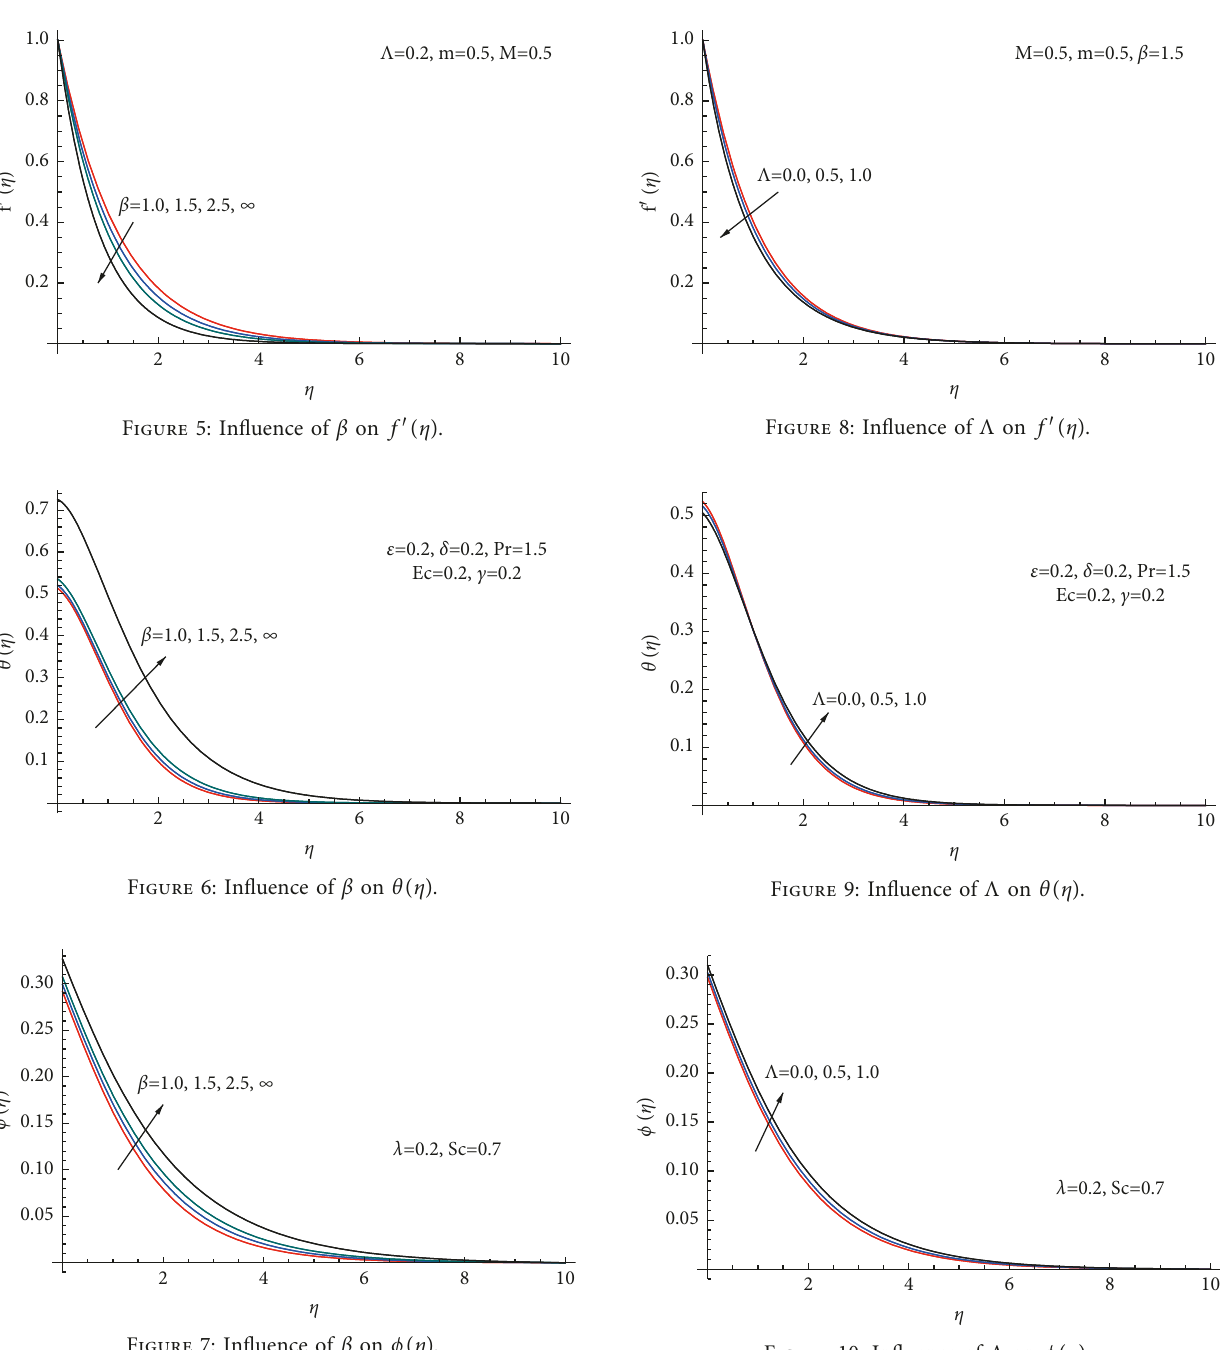
Figure 10: Influence of Λ on ϕ ( η )